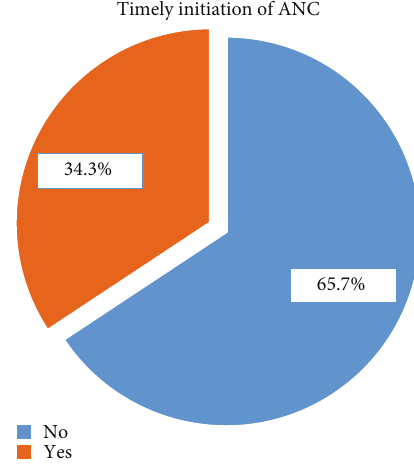
Figure 1: Prevalence of timely initiation of ANC among pregnant women attending ANC clinic in Wachemo University Nigist Eleni Mohammed memorial comprehensive specialized hospital,